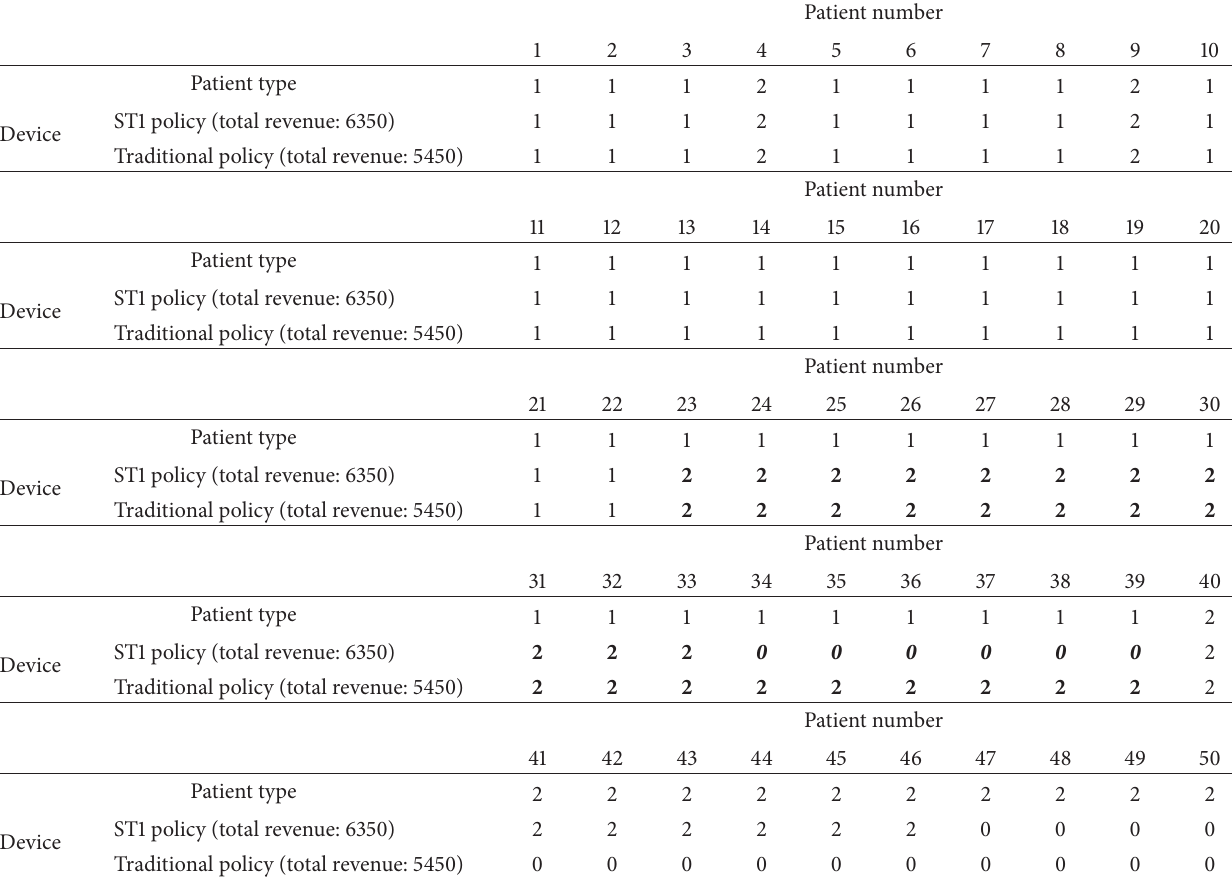
Table 2: Comparison of two strategies in Case